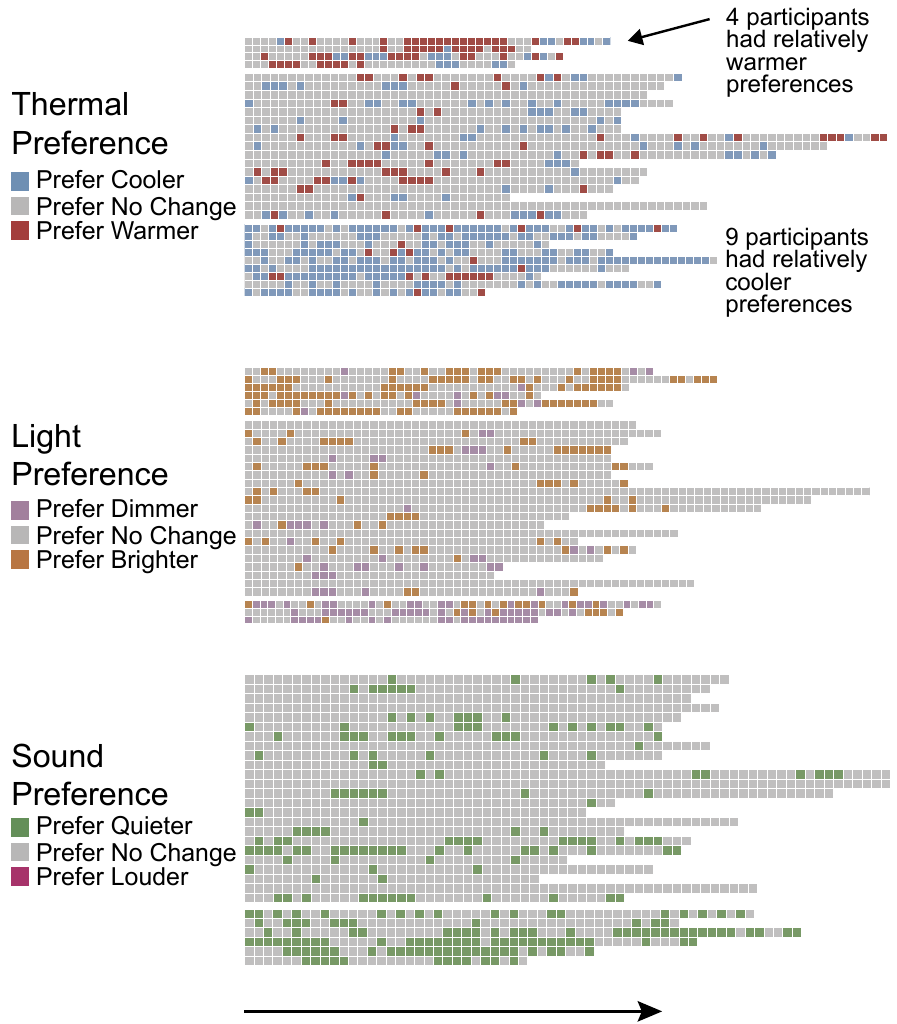
Figure 4. Overview of the intensive longitudinal data collected from the occupants according to the three categories. Each row is an occupant and each box in that row shows that occupant’s feedback answers collected sequentially. The visualisation is diagrammatic in that vertical alignment of the boxes between different occupants does not imply identical time